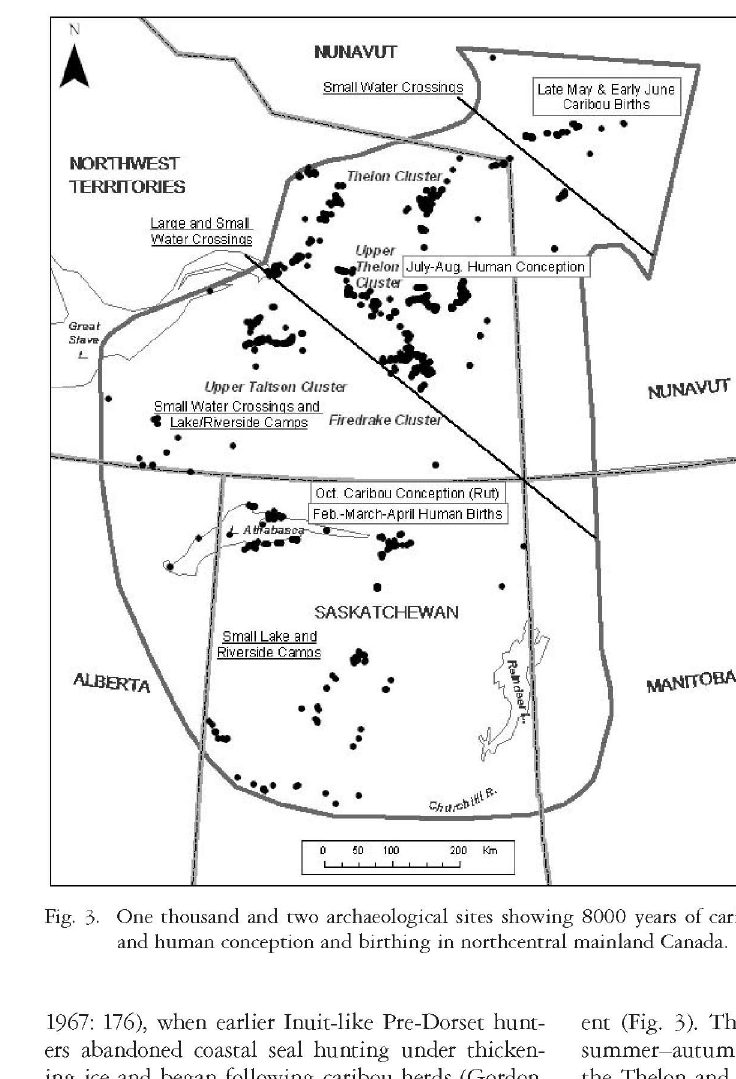
Fig. 3. One thousand and two archaeological sites showing 8000 years of caribou and human conception and birthing in northcentral mainland